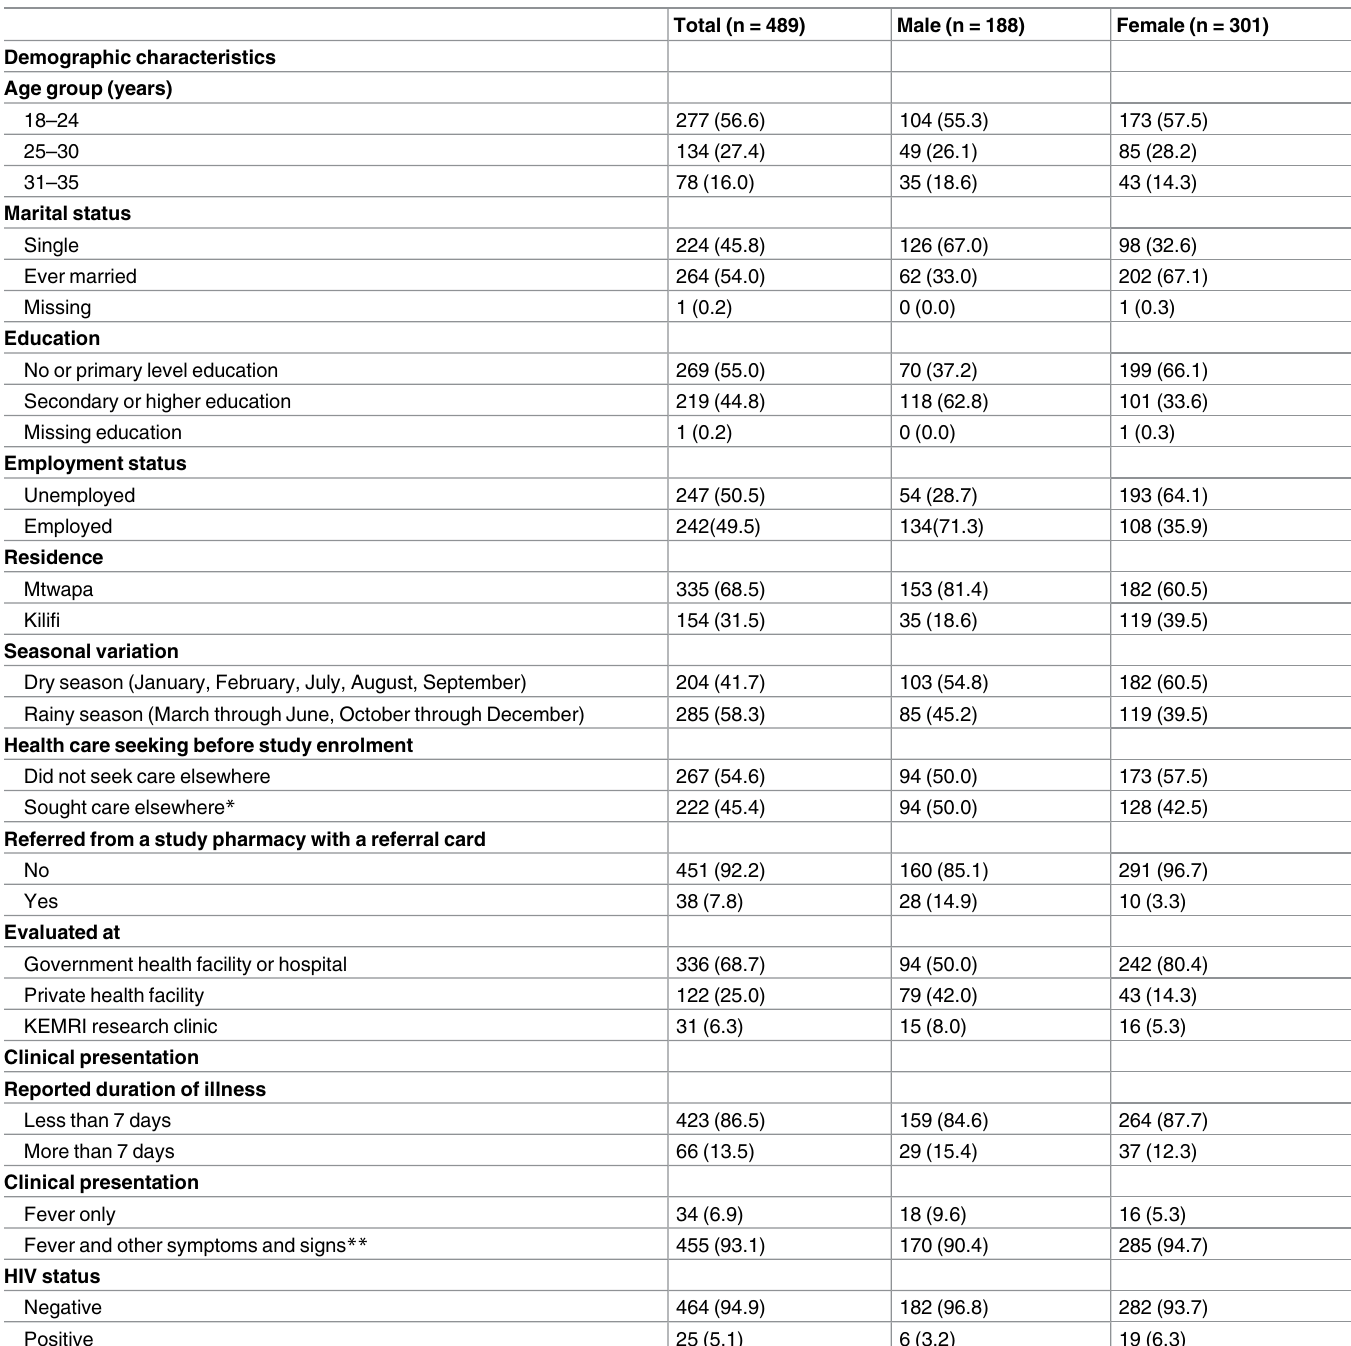
Table 1. Demographic and clinical characteristics of study participants (N =